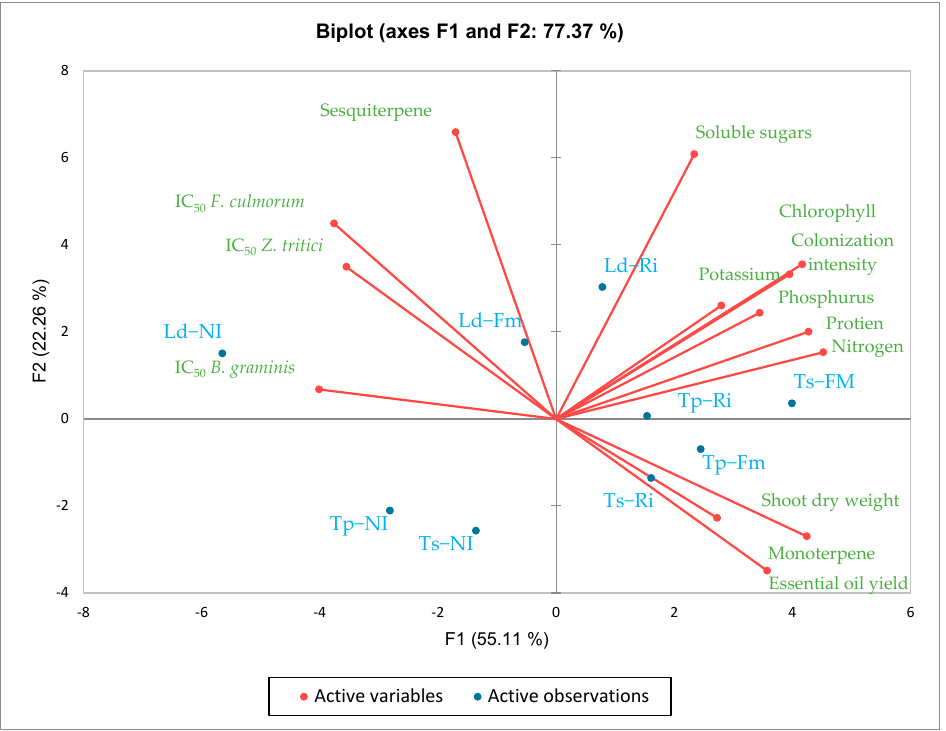
Figure 12. Correlation circles from the principal component statistical analyses (PCA) on different parameters studied for Thymus satureioides (Ts), Thymus pallidus (Tp), and Lavandula dentata (Ld), non-inoculated (NI) or inoculated with Rhizophagus irregularis , (Ri) or Funneliformis mosseae . Regarding the chemical composition of essential oil, no significant difference was de- tected between mycorrhizal and non-mycorrhizal plants. However, the abundance of the major compounds significantly varied according to AMF and AMP species. The abun- dance of oxygenated monoterpenes was higher in T. satureioides and L. dentata essential oils. However, in T. pallidus essential oil, there are hydrocarbon monoterpenes and oxy- genate sesquiterpenes with a higher percentage. Concomitantly, hydrocarbon monoter- penes decreased in the essential oil of T. satureioides and L. dentata , while oxygenated mon- oterpenes decreased in the essential oil of T. pallidus . These results support the fact that the AMP studied are AMF dependent [73–76]. Indeed, the essential oil of T. satureioides inoculated with F. mosseae is characterized by a higher abundance of carvacrol, linalool, thymol, β -caryophyllene, carvacrol methyl ether, terpinene-,4-ol, and borneol compared to the plant inoculated with R. irregularis (Figure 13A). However, in T. pallidus , association with F. mosseae exhibited a higher abundance of caryophyllene, α -terpinene, and (+)-4- carene, in addition to other compounds such as γ -terpinene, camphene, verbenene, and